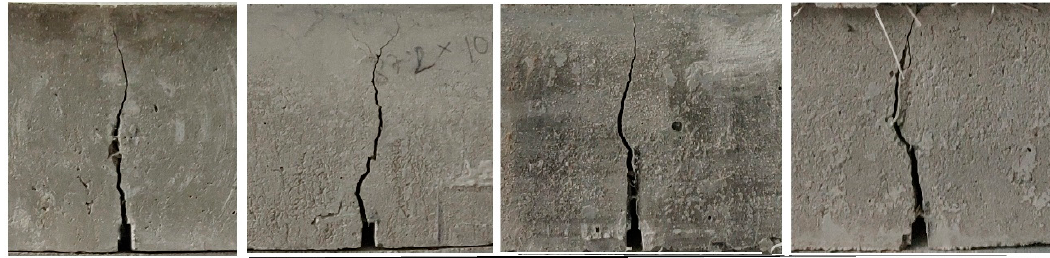
Figure 4. Concrete cracks after the test.